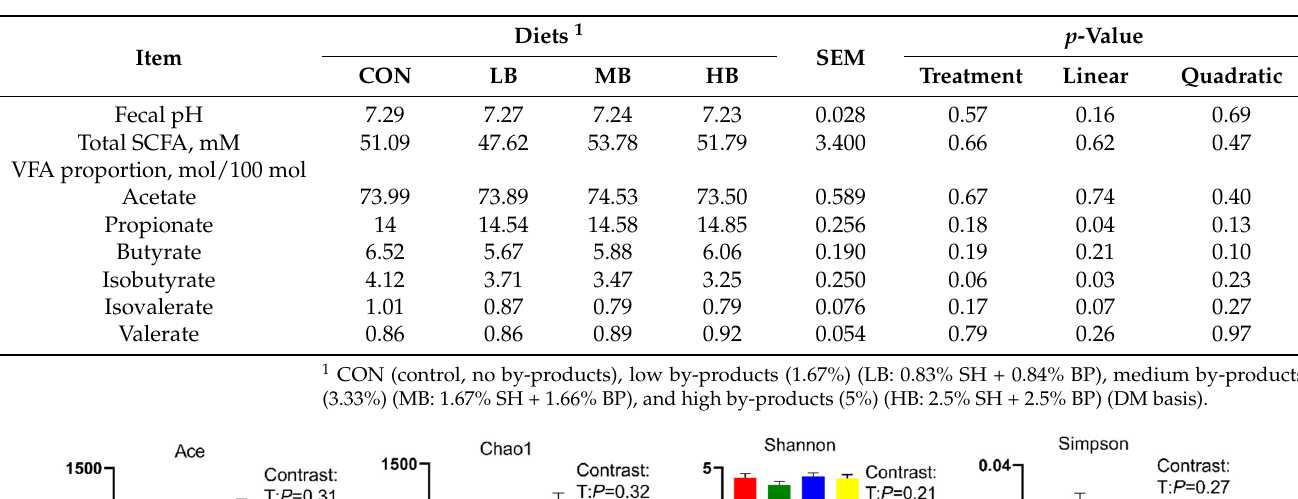
Table 2. Fecal short-chain fatty acid (SCFA) profile of lactating Holstein cows fed diets with by- products substituted for forage.